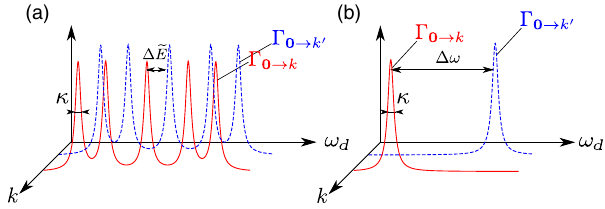
FIG. 3. Schematics of the pumping rate Γ 0 → as a function of k the drive frequency ω for N ¼ 5 . (a) Driving first cavity only: d Any of the five photon-fluctuation modes (responsible for the five peaks) can be used for dissipative stabilization. Driving to j k i while avoiding populating the nearest state j k 0 i necessitates − ~ E ∼ 2 π J ð g= Δ Þ 2 =N . (b) Driving all cavities κ < Δ ~ E ≡ j ~ E k k 0 j